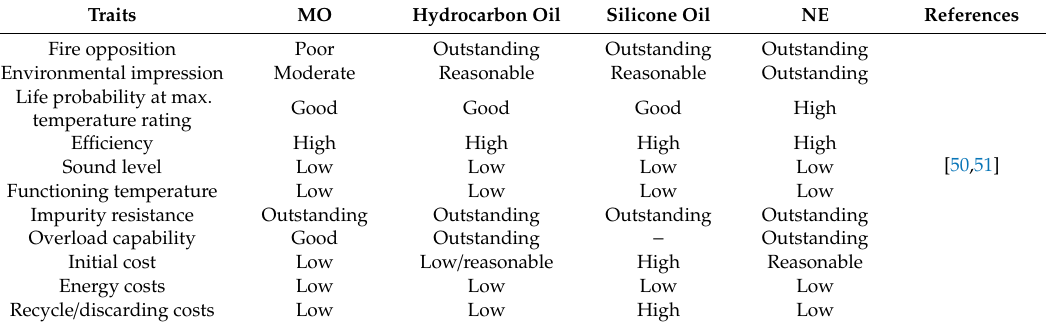
Table 12. Relative evaluation of extraordinary fire point and smaller inflammable fluid immersed transformer categories and their